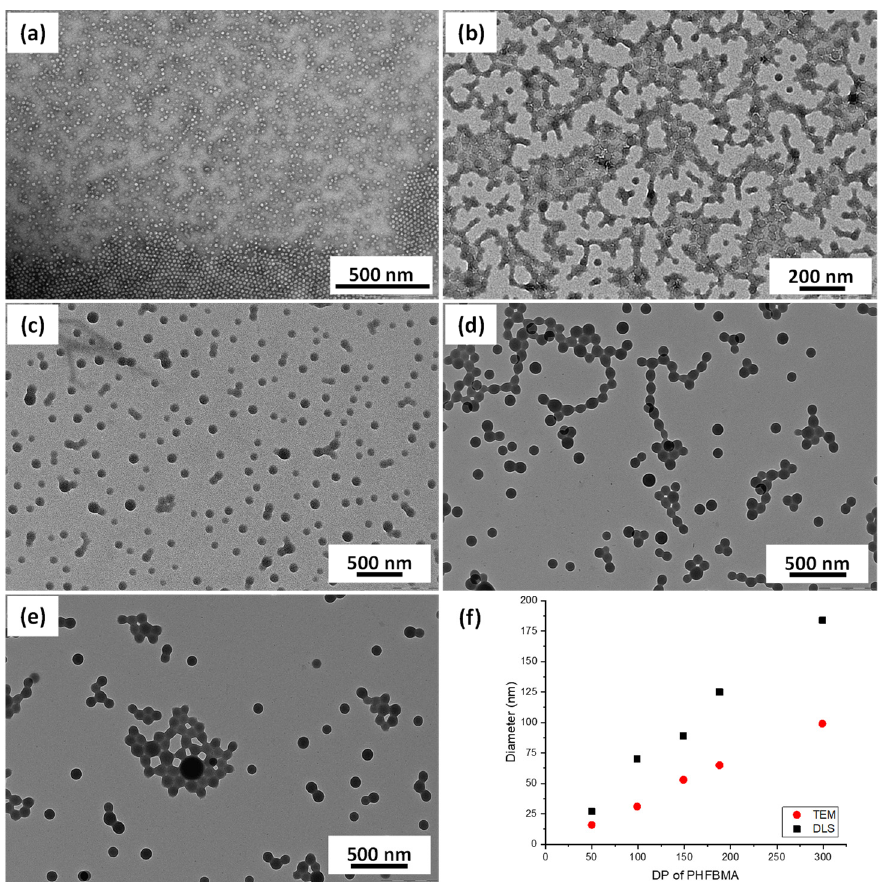
Figure 3. TEM images obtained for PDMA 39 –PHFBMA x nanoobjects prepared at 10% w / w via RAFT alcoholic dispersion polymerization of HFBMA with ( a ) x = 50, ( b ) x = 99, ( c ) x = 149, ( d ) x = 188, and ( e ) x = 299. ( f ) Evolution of the average particles diameter measured by TEM (red dots) and DLS (black squares) with the DP of the PHFBMA core-forming block.